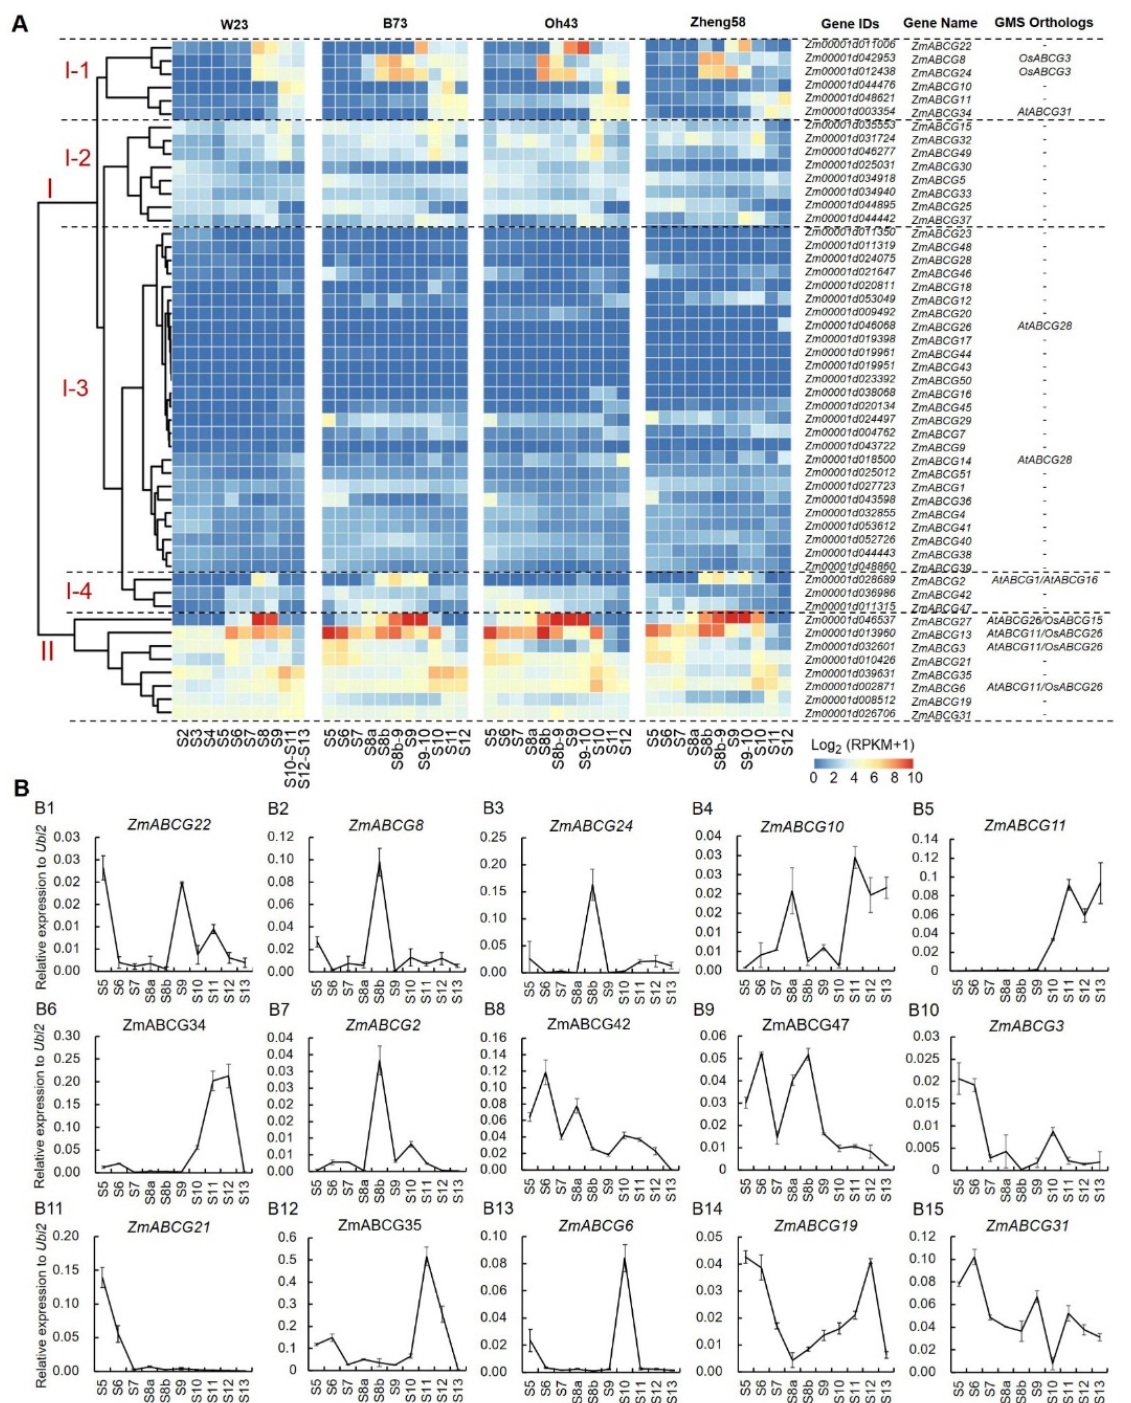
Figure 4. Expression analysis of ABCG genes in maize. ( A ) Expression analysis of 51 ABCG genes in maize based on RNA-seq data in maize inbred lines W23, B73, Oh43 and Zheng58. These genes are clustered into two clusters. Genes in cluster I were clustered into four sub-clusters. ( B ) qPCR analysis of 15 ABCG genes from sub-clusters I-1, I-2, and cluster II in developing anthers from stages 5 to 13 (S5–S13). Data are means ± SD, n = 3.